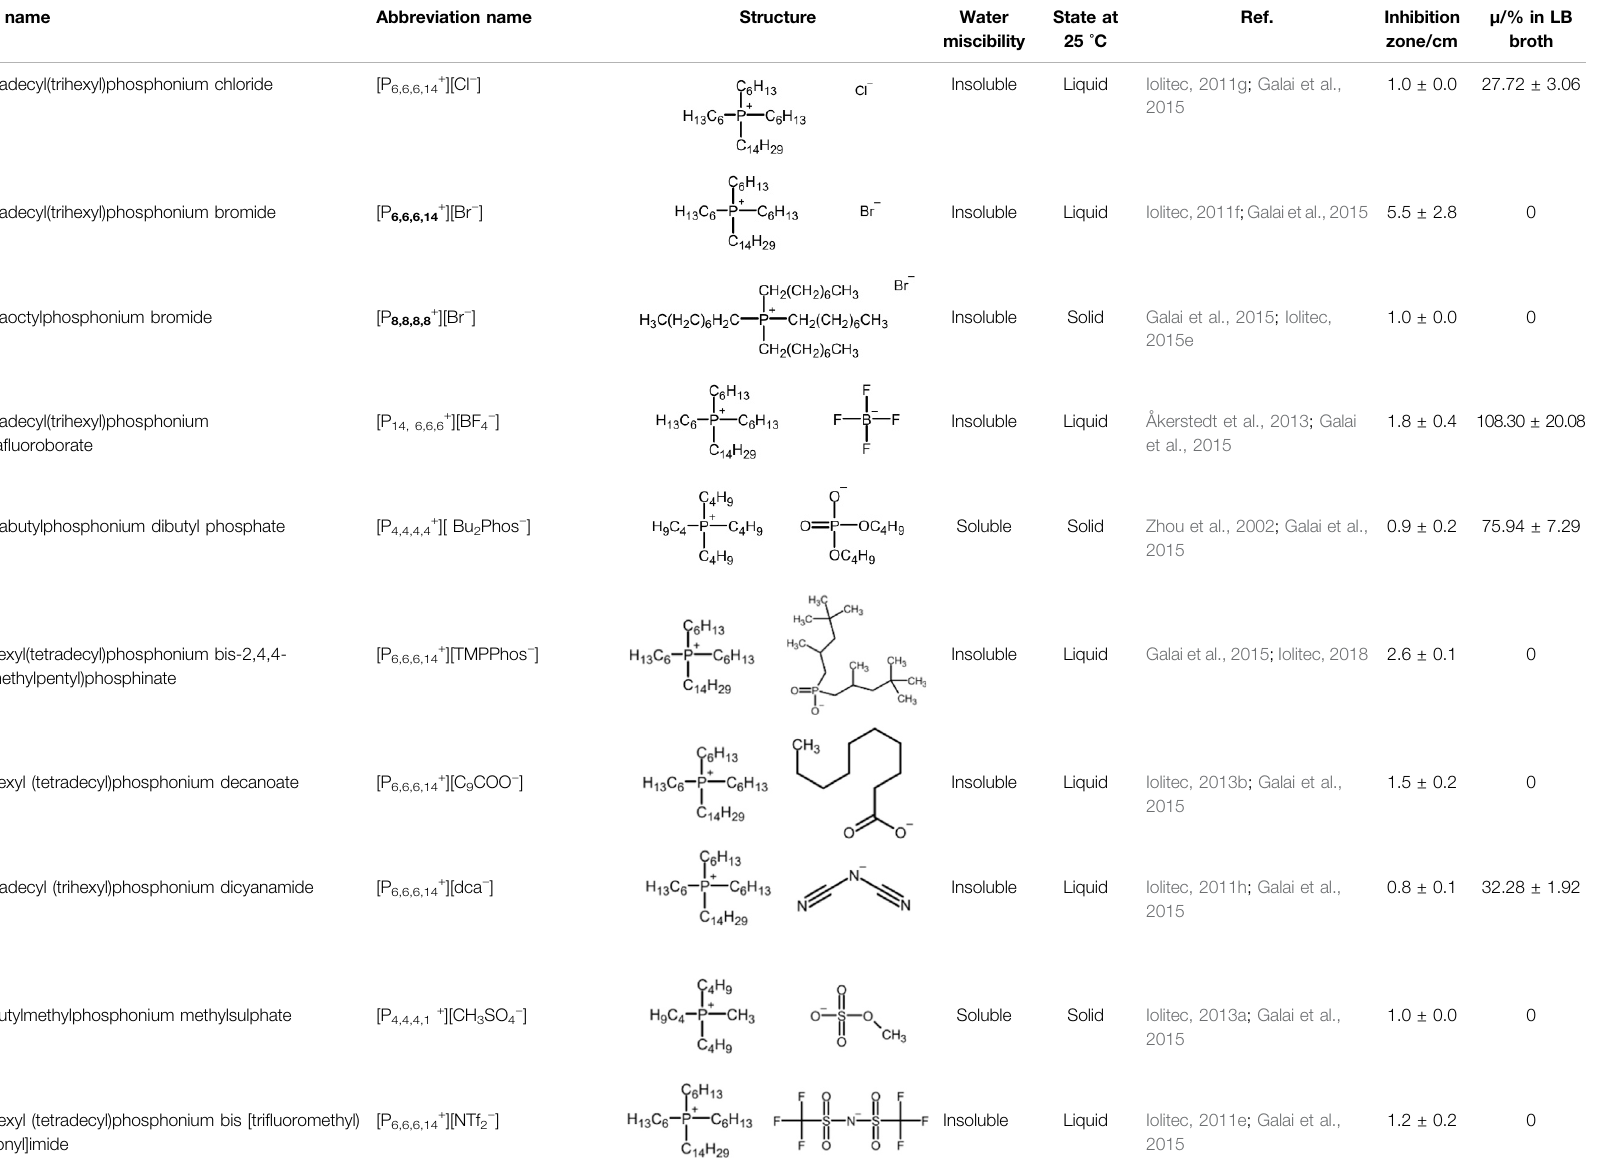
TABLE 8 | Phosphonium-based ionic